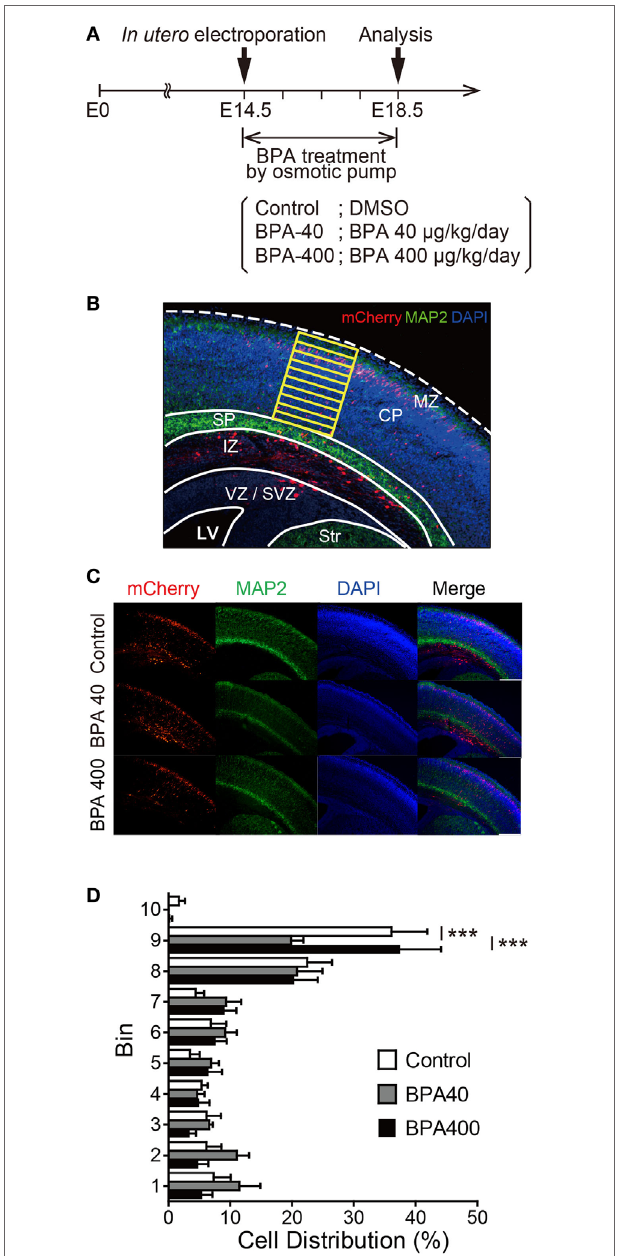
FigUre 1 | effects of prenatal BPa exposure on neuronal migration in the developing cerebral cortex. (a) Diagram of the experiment design. (B) Bin analysis was performed to evaluate differences in cell distribution. MZ, marginal zone; CP, cortical plate; SP, subplate; IZ, intermediate zone; SVZ, subventricular zone; VZ, ventricular zone; LV, lateral ventricle; Str, striatum. (c) Representative photographs of brain sections in the Control, BPA-40, and BPA-400 groups. (D) Distribution of mCherry-positive neurons in the CP at E18.5. Data are shown as mean ± SEM, n = 4 (control), n = 5 (BPA-40), n = 5 (BPA-400), *** p < 0.01.